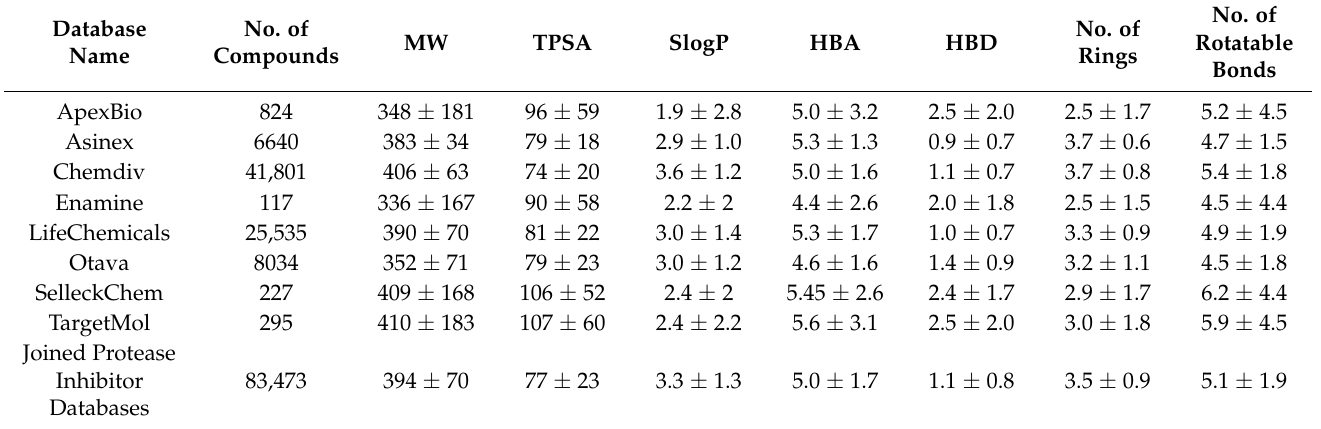
Table 4. Analysis of the most important descriptors for the protease-inhibitor-targeted library.